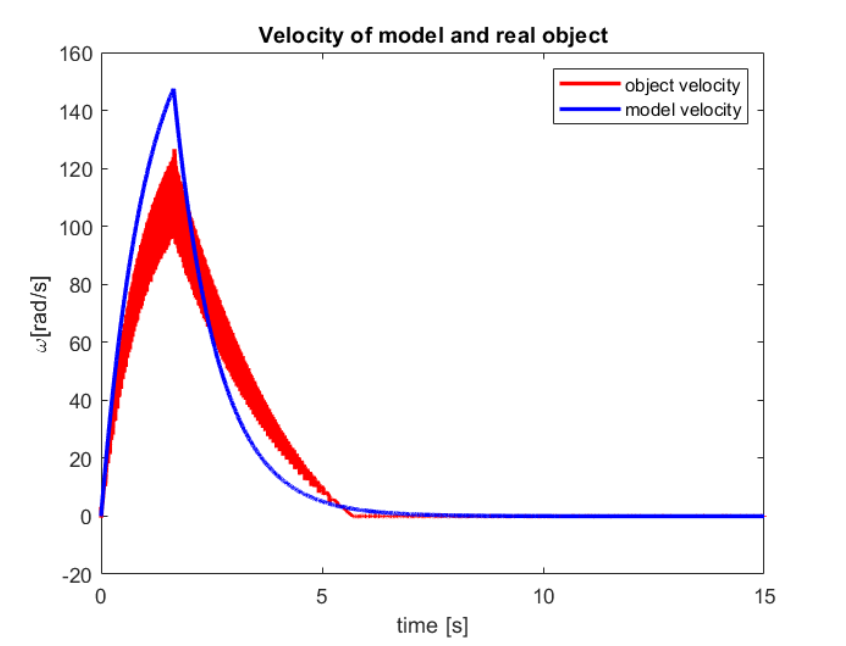
Figure 13. The received velocity of the model and the sensor-aided object for 300 ◦ reference value (source: